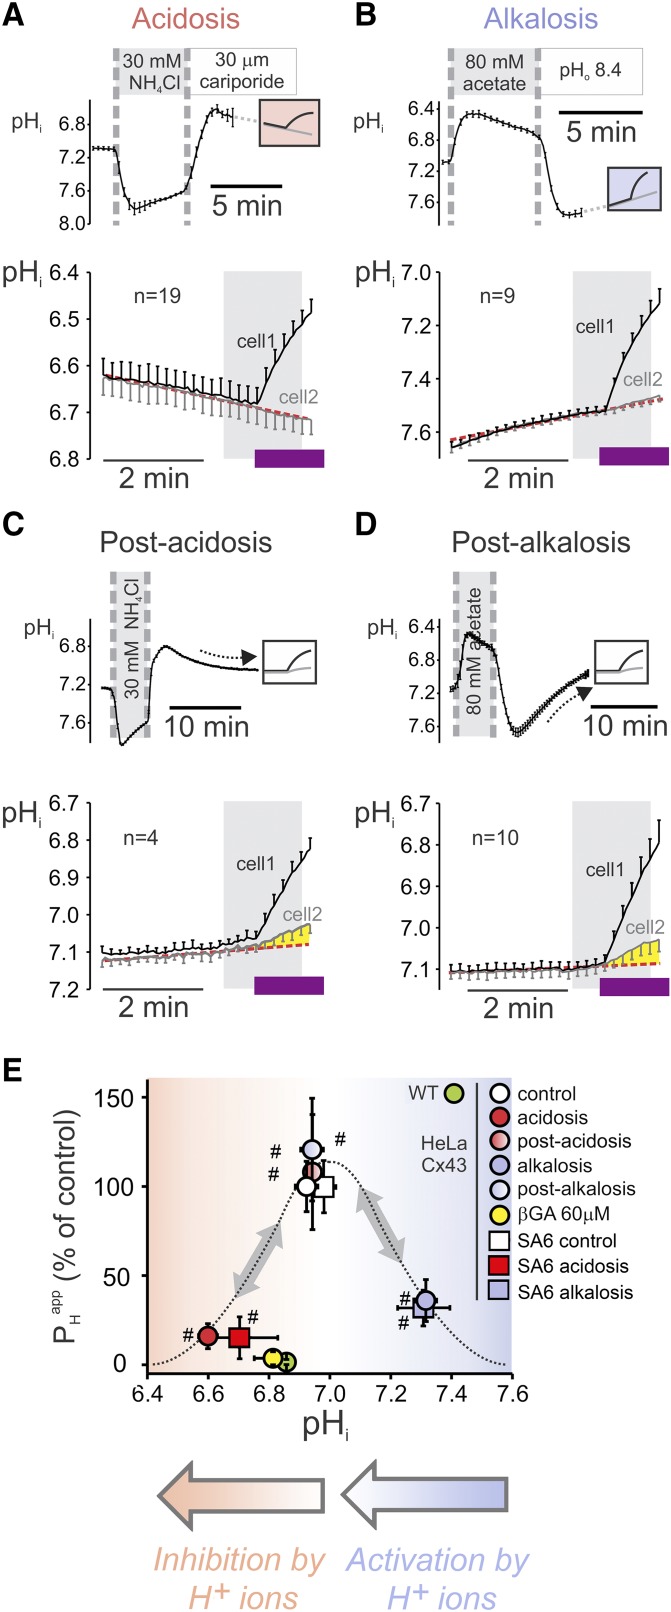
Reversibility of pHi gating. A) Resting pHi in Cx43-transfected N2a cell pairs was preadjusted to acidic before H+ uncaging by 30 mM NH4Cl prepulse (returned to normal Tyrode that contained 30 µM dimethylamiloride to inhibit pHi recovery). pHi time course (bottom) for estimating junctional H+ ion permeability (PHapp) showing reduced transmission. B) Resting pHi preadjusted to alkaline before H+ uncaging by 80 mM Na+ acetate prepulse (returned to normal Tyrode at pH 8.4 to slow pHi recovery). pHi time course (bottom) for estimating PHapp shows significant reduction in transmission. C) Acid block was reversed after allowing 10 min of recovery from acidic pHi. D) Alkali block was reversed after allowing 10 min of recovery from alkaline pHi. Shaded regions correspond to the period we used to fit data using mathematical models. Purple bands correspond to the uncaging period (flash photolysis). E) Summary of reversibility results were fitted to a bell curve. Added to this data are the results obtained from acidosis and alkalosis experiments performed by using Cx43 mutants where all serine residues from the PKC epitope at the end of the C tail have been substituted by alanine residues (SA6). Activation and inhibition by H+ ions are highlighted by gray arrows. #Significantly different from 0.